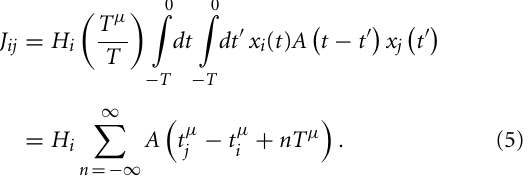
] − 1 , a = [ η + T p / T ] − 1 , T p = 10 . 2 ms, D D D